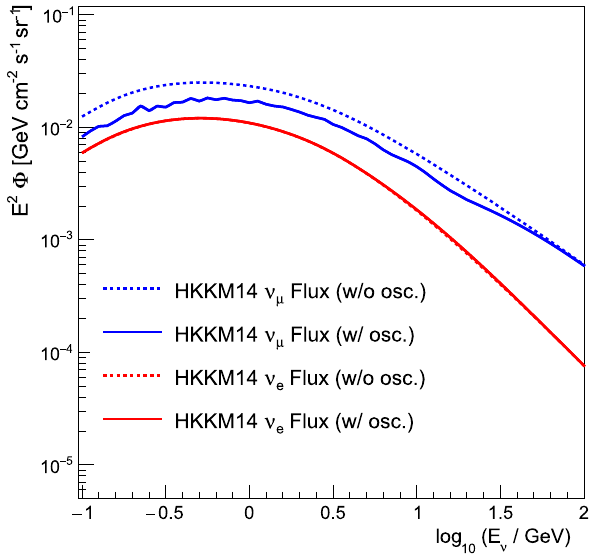
Fig. 3 Expected atmospheric (neutrino + antineutrino) flux at the JUNO site, for ν e (red) and ν μ (blue), according to the HKKM14 model [33]. The flux is reported with (full line) and without (dashed line) con- sidering neutrino